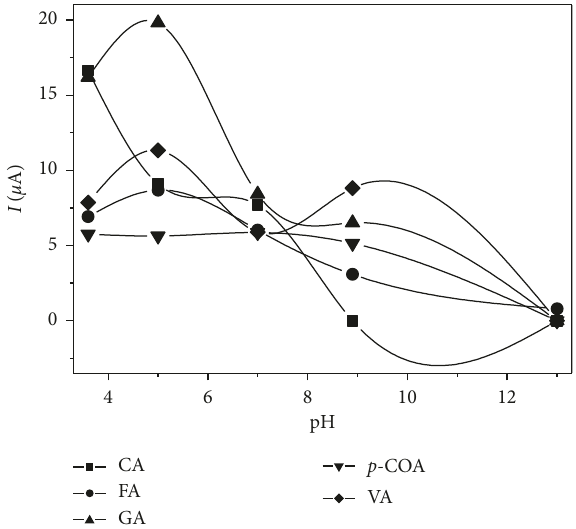
Figure 1: Effect of pH on first anodic peak current of studied phenolic acids employing 0.1mol 1 . CA: caffeic acid (180.2mg 50mVs 1 ); GA: gallic acid (170.1mg (194.2mg L − · acid −